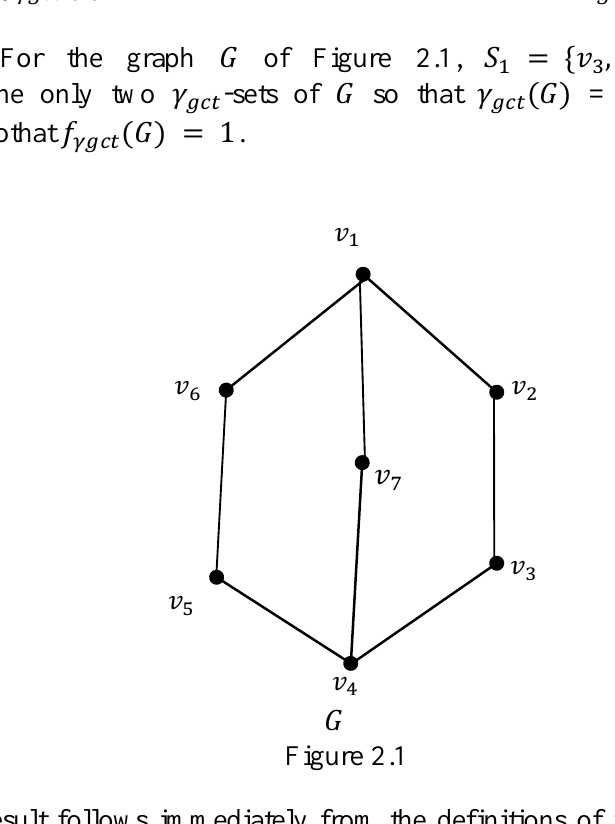
= {𝑣 1 (𝐺) = 3 and 𝑓 𝑔𝑐𝑡